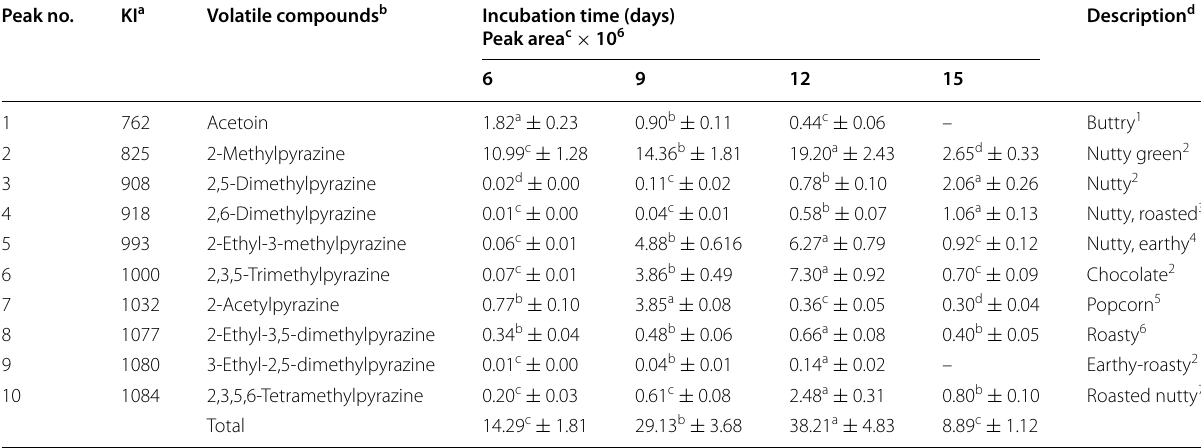
a Retention indices of volatile compounds on DB-5 column b Compounds listed according to their elution on DB-5 column c Values 10 6 , expressed as total ion chromatograms(TIC) of GC-MS ( n × d Volatile compound description was performed according to 1 Forster et al. [25], 2 Adams and De-Kimpe [2], 3 Bonvechi [26], 4 Frederick et al. [1], 5 Muller and Rappert [24], 6 Yan et a1 [27]., 7 Afoakwa et al. [28]. Mean values in the same row for each culture followed by different superscript lower case letters are significantly different at P <